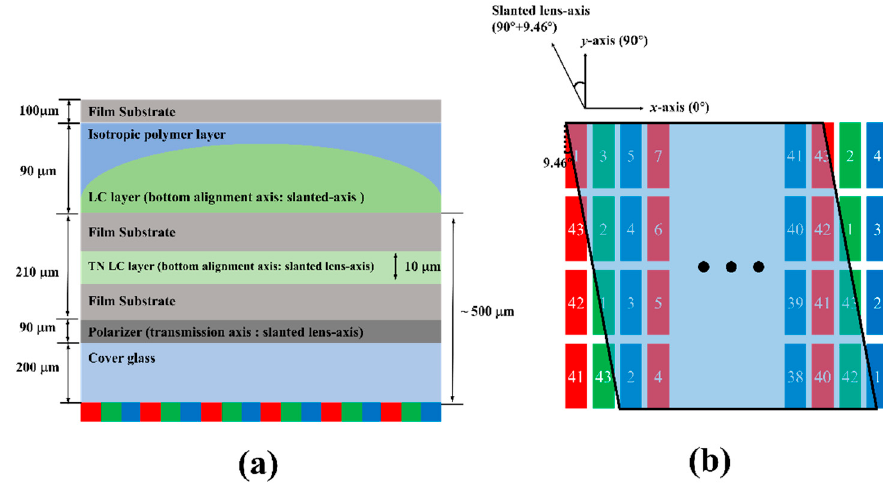
Figure 9. ( a ) Cross-sectional schematic of the polarization-dependent-switching high- ∆ n LC GRIN lens array assembled on the quad high-definition (QHD) (750.6 ppi) mobile panel for realizing a 2D / 3D switchable display. ( b ) Subpixel rearrangement for the 43-view autostereoscopic 3D display operating through the polarization-dependent-switching LC GRIN lens array.